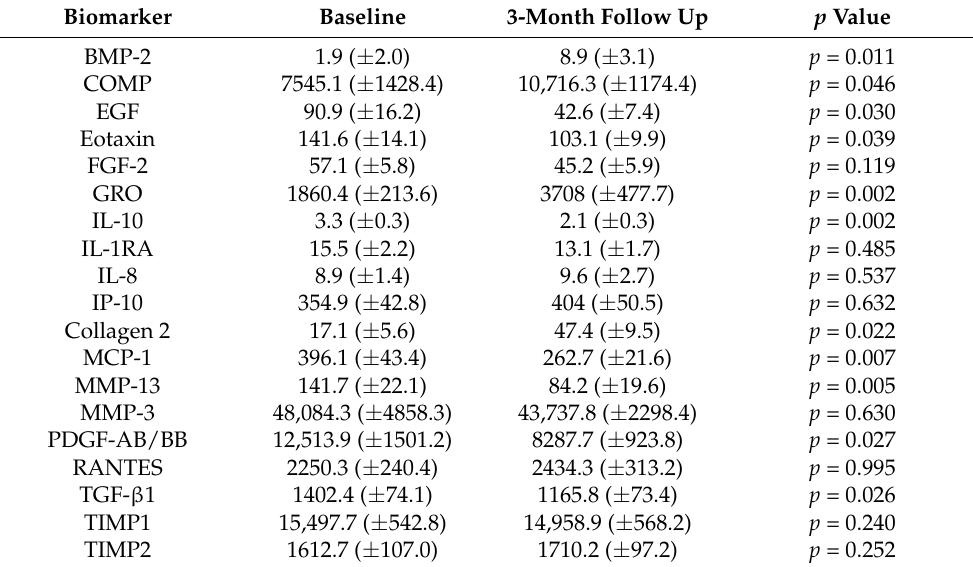
Table 3. Summary of biomarker levels in the